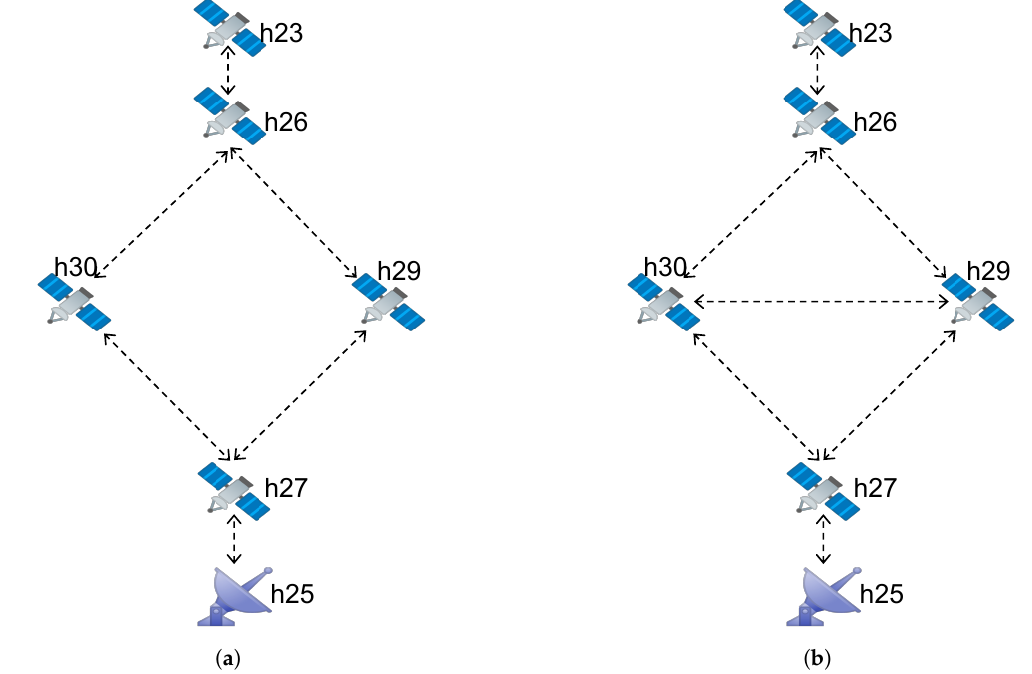
Figure 2. Space-based information network of satellites and a GS. ( a ) Topology 1 ( b ) Topology